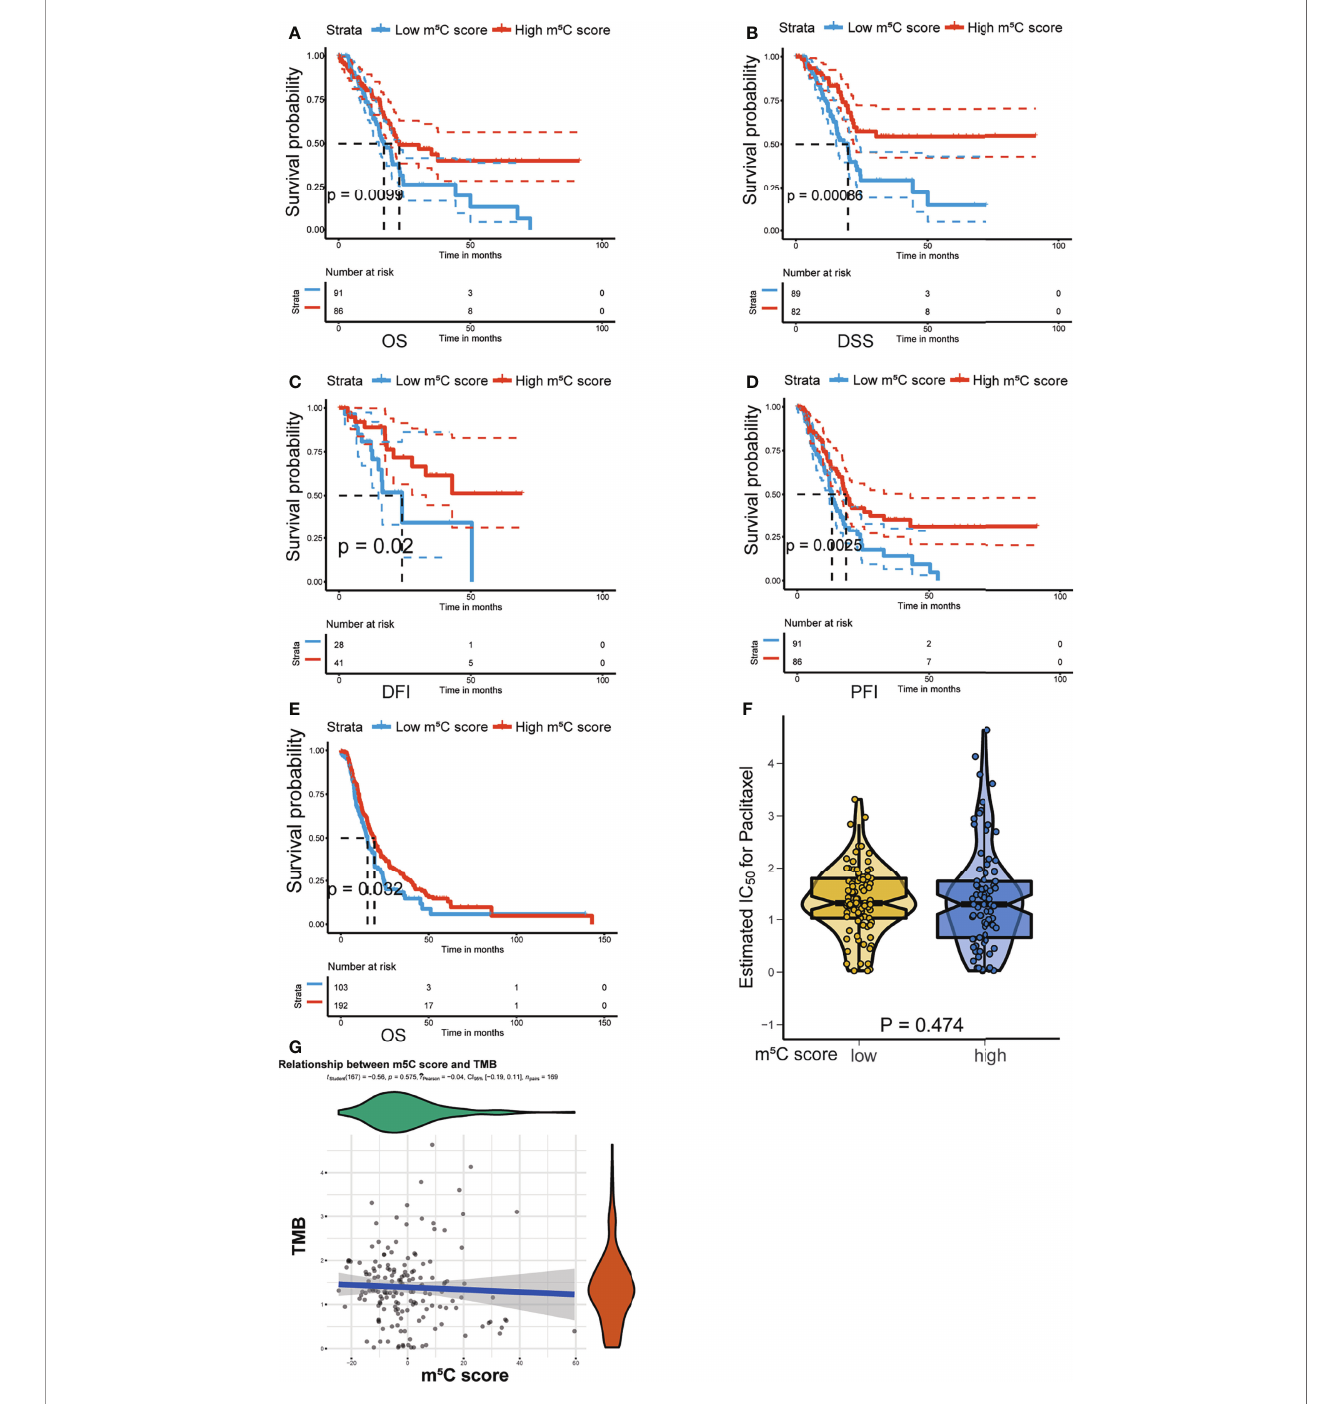
FIGURE 8 | Validation of the utility of the m 5 C score in predicting PAAD patient prognosis. (A – D) Kaplan – Meier curves of overall survival (OS), disease-speci fi c survival (DSS), disease-free interval (DFI), and progression-free interval (PFI) for patients with PAAD in the high and low m 5 C score groups in the TCGA PAAD dataset. (E) Kaplan – Meier curves of overall survival (OS) for patients with PAAD in the high and low m 5 C score groups in the ICGC-AU and ICGC-CA datasets. (F, G) Correlation between the m 5 C score and tumor mutation burden